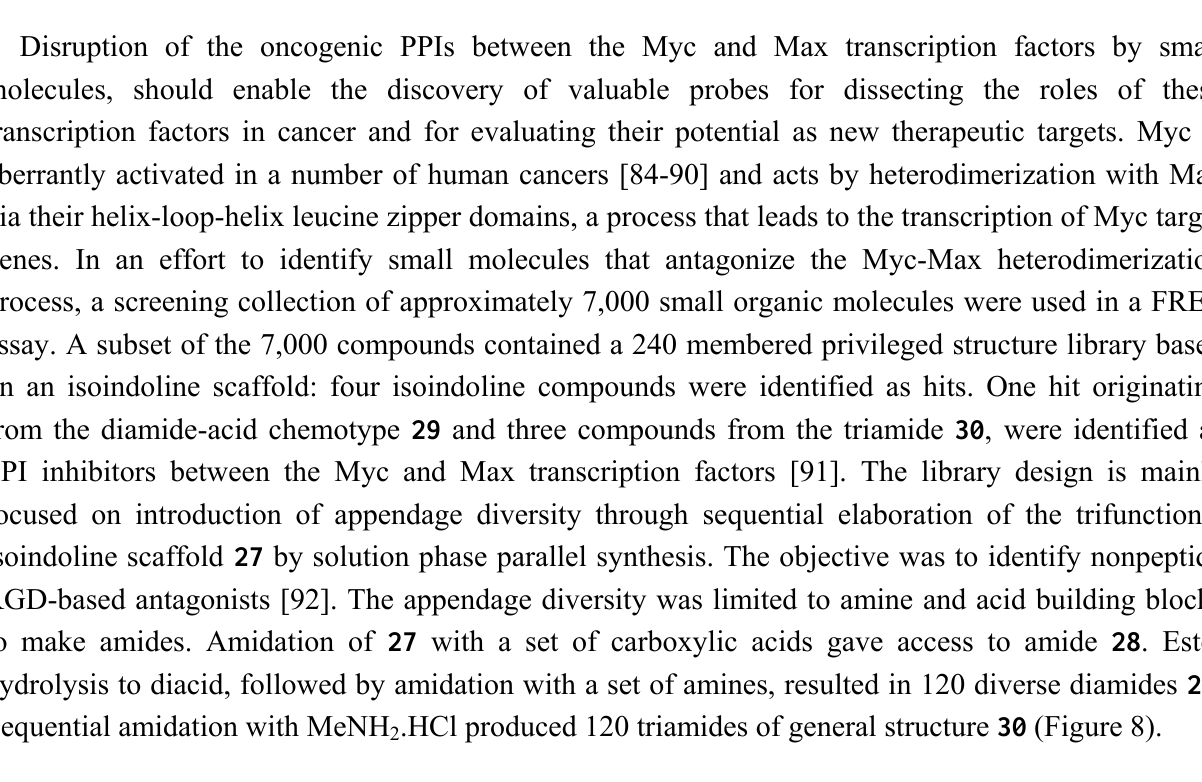
Figure 8. Isoindoline-based antagonists of the Myc-Max protein-protein